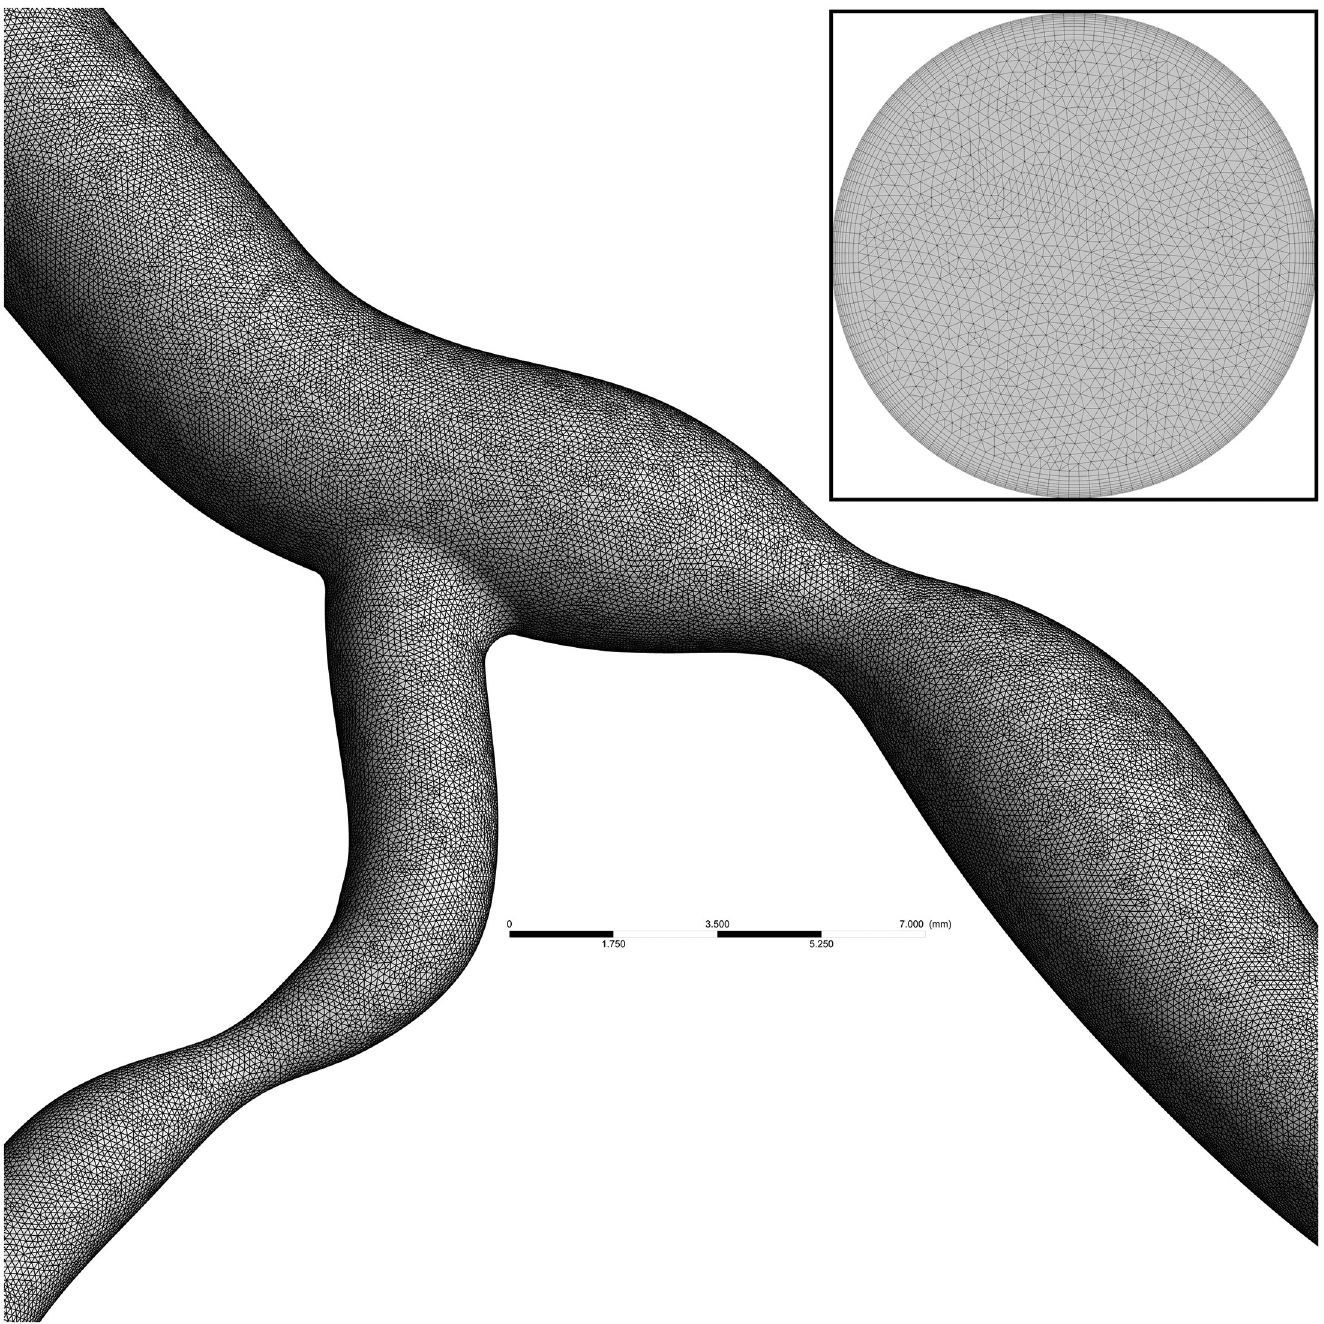
Fig 6. Mesh on surface of diseased coronary artery bifurcation and a cross section at inlet showing inflation layers near boundary.